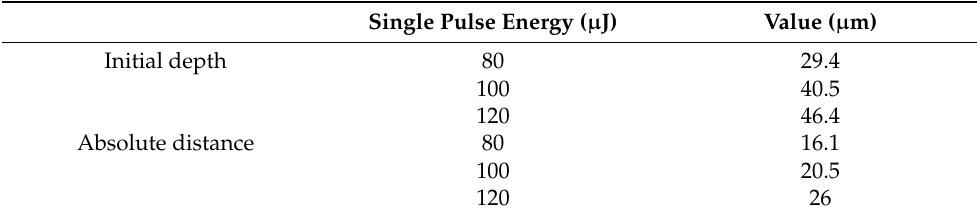
Table 3. Additional processing parameters of femtosecond laser ablation for TTM